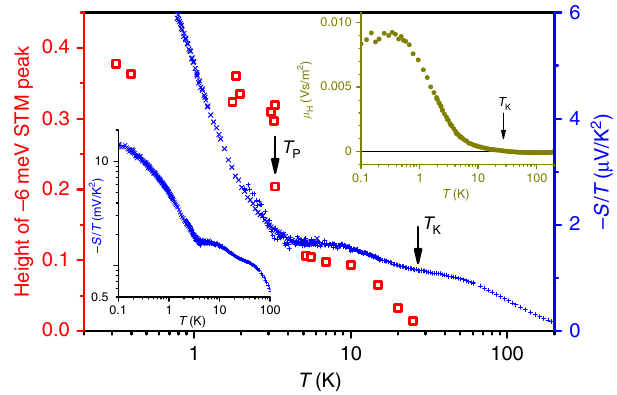
Fig. 4 Development of lattice Kondo correlations. The height of the Kondo lattice peak (red squares) is compared to thermopower S divided by T (blue crosses) in dependence on T . Low-temperature data ( T ≤ 6 K) were taken from ref. 35 . Left inset: same S / T -data on a logarithmic scale to show broader range. Right inset: Hall mobility μ H vs . T . All three properties exhibit a strong upturn below T P ≈ 3.3 K and saturation at lowest